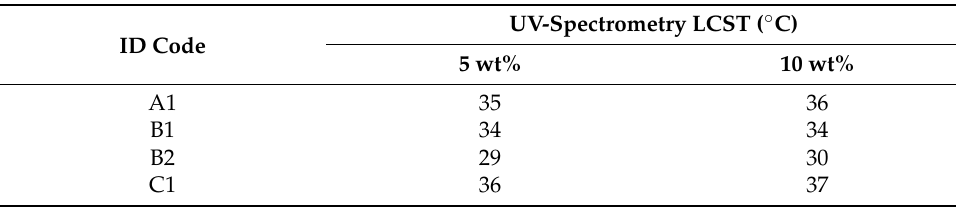
Figure 6. Cloud point analysis of PNVCL, PNVCL/VAc, and PNVCL/NVP for both 5 and 10 wt% polymer samples. Error bars represent the standard error from the mean. Table 5. The LCST ( ◦ C) results were obtained for the 5 and 10 wt% PNVCL, PNVCL/Vac, and PNVCL/NVP aqueous polymer